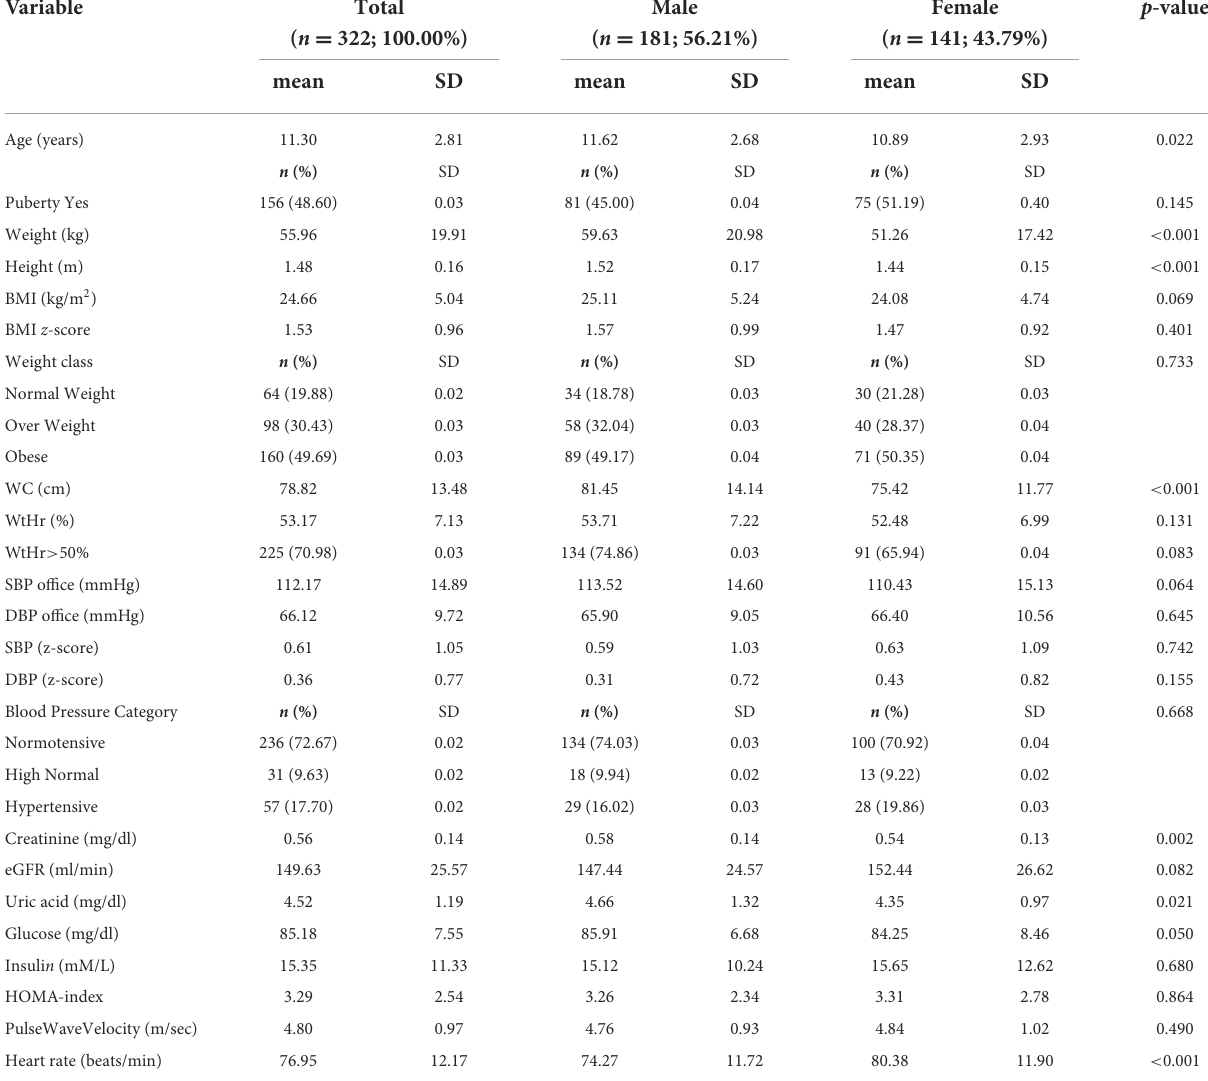
TABLE 1 Anthropometric and clinical characteristics of the study population.